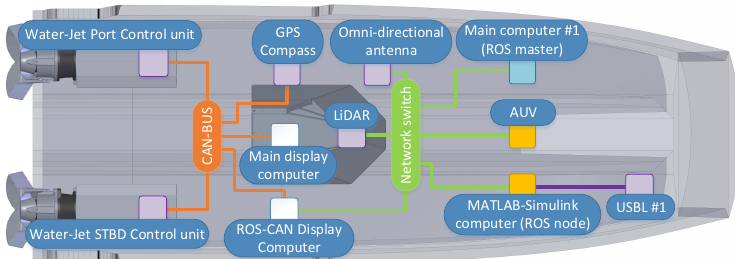
Figure 10. System overview of the USV platform with high-level (blue boxes),intermediate-level (white boxes), and low-level control (purple boxes), including the connection to the AUV platform (adapted from [10]).